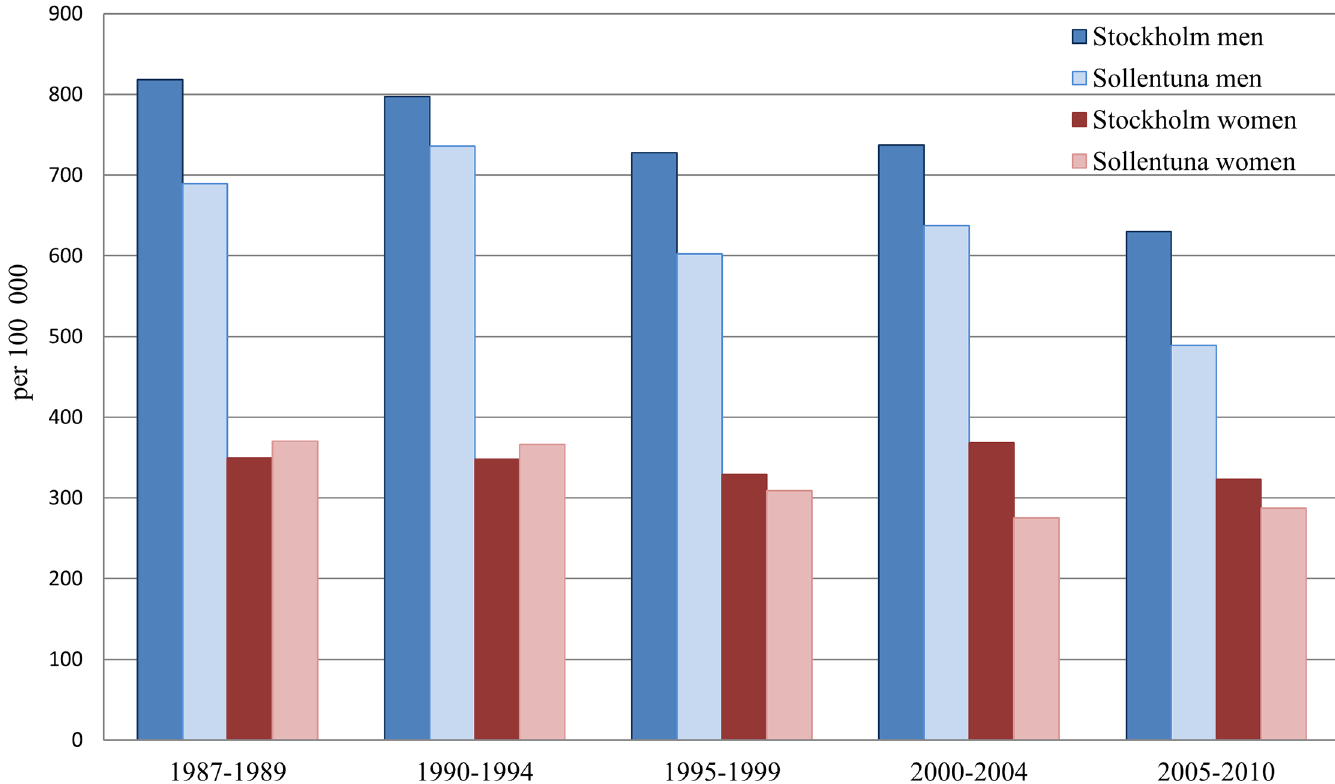
Fig 1. Age standardized AMI incidence in men and women per 100 000 inhabitants in Stockholm and Sollentuna in five year groups between 1987 to 2010.